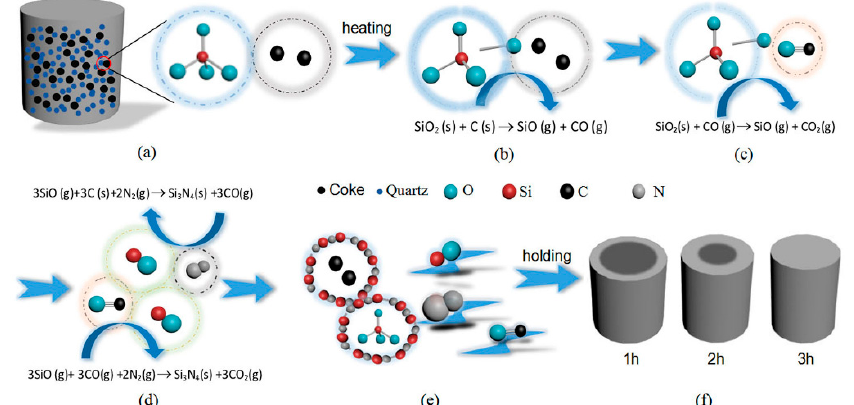
Figure 5. Reaction schematic diagram for the formation of β -Si 3 N 4 by carbothermal reduction-nitridation (CRN) of quartz: ( a ) the green body of specimen, ( b – e ) nitridation processes of raw materials, ( f ) specimens obtained under different holding times.